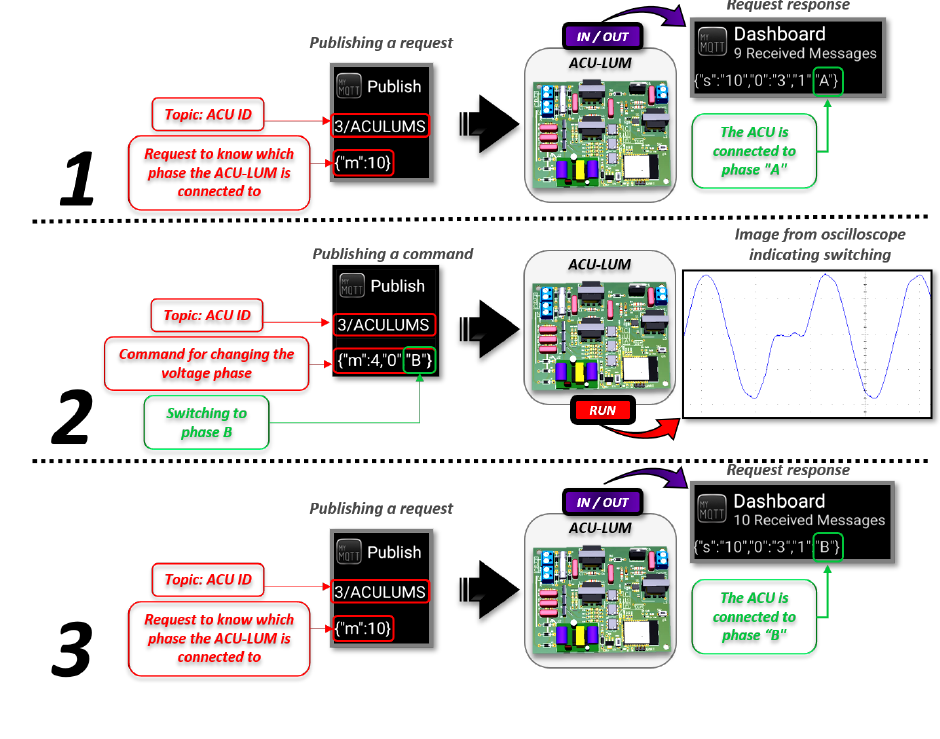
Figure 16. Procedures for validating the ACU-LUM phase-switching